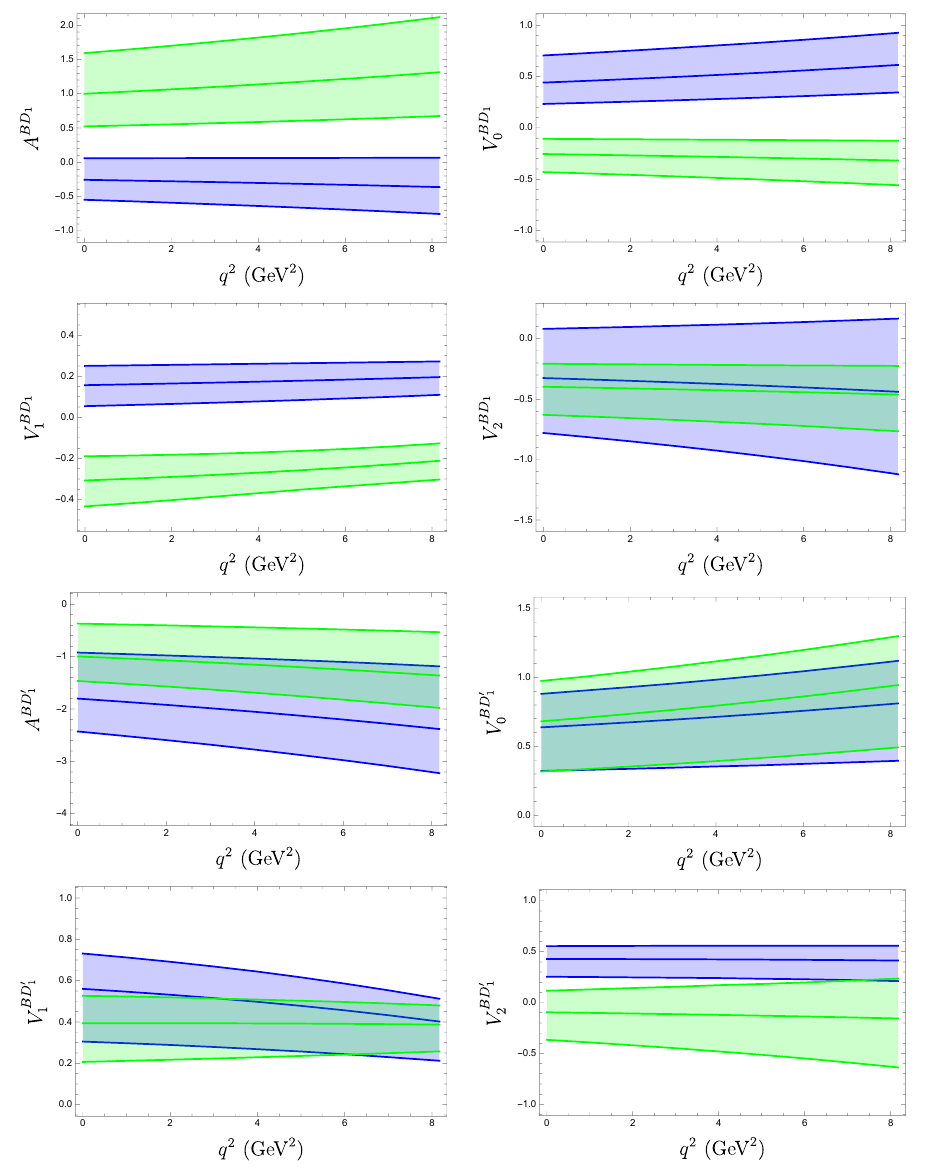
form factors. The central values and 1